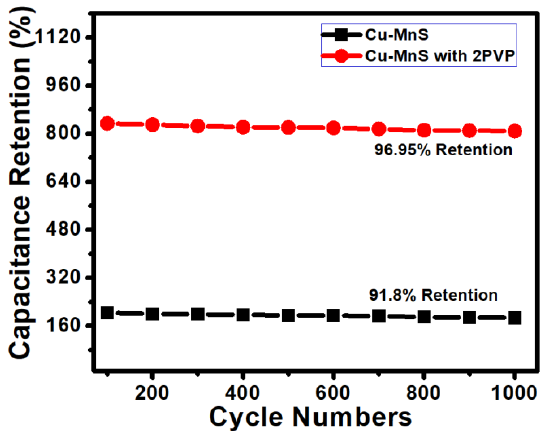
Figure 9. Capacitance retention as a function of the cycle numbers at current density of 1 A g −1 in 2 M KOH solution.